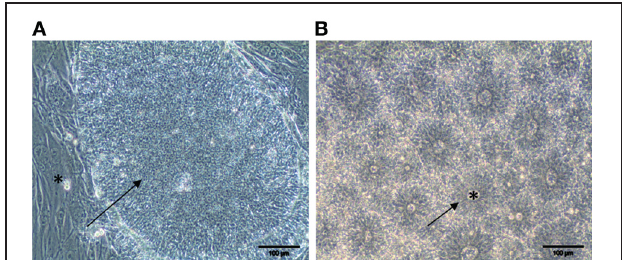
FIGURE 1 | Commitment of hPSC along the neural lineage. (A) Phase contrast morphology of a colony of undifferentiated pluripotent hESC (arrow) cultivated on a feeder layer of mouse fibroblast (star). (B) After eight days of treatment with the BMP antagonist Noggin and the Activin inhibitor SB431542, structures resembling the neural tube are clearly identifiable. Neuro-epithelial cells form an epithelium (arrow) surrounding a lumen (star). Scale bar: 100 μ